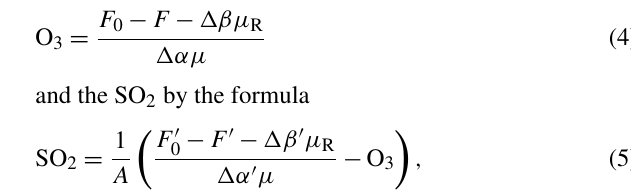
Figure 1. All stations with accessible SO 2 column data from Brew- ers analysed in this study as listed in Table